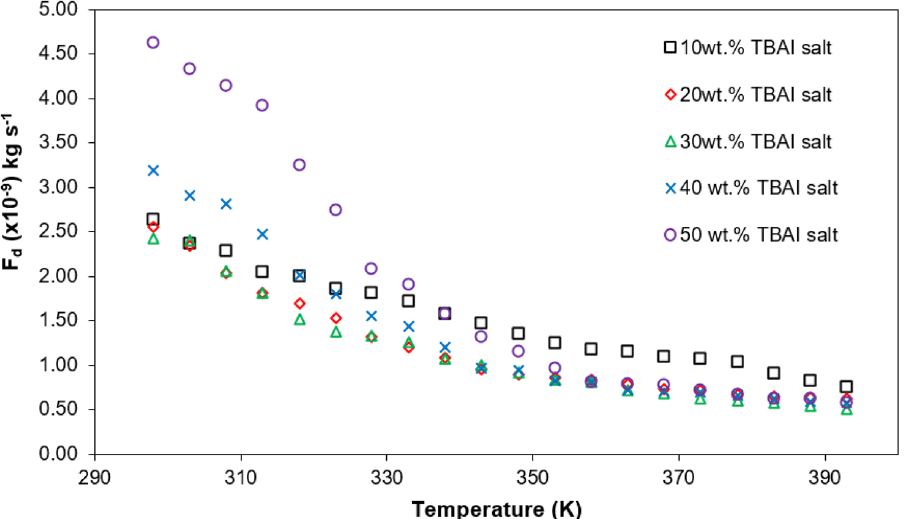
Figure 4. Stoke drag, F d for various TBAI salt concentrations at selected